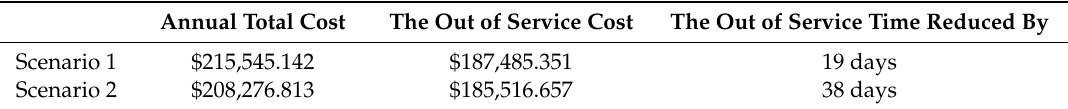
Table 3. The result summary of Scenario 1 and Scenario 2.